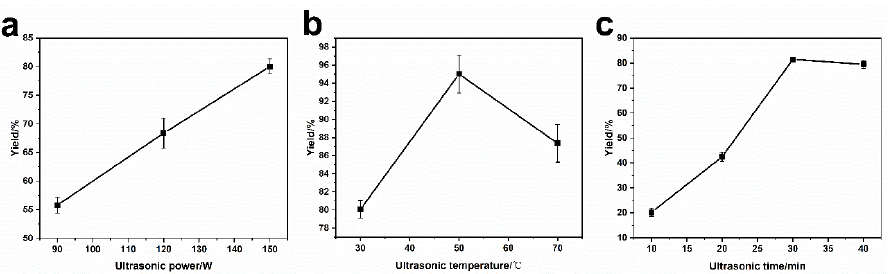
Figure 4. Ultrasonic conditions of liposomes preparation with respect to ultrasonic power ( a ), ultrasonic temperature ( b ), and ultrasonic time ( c ).